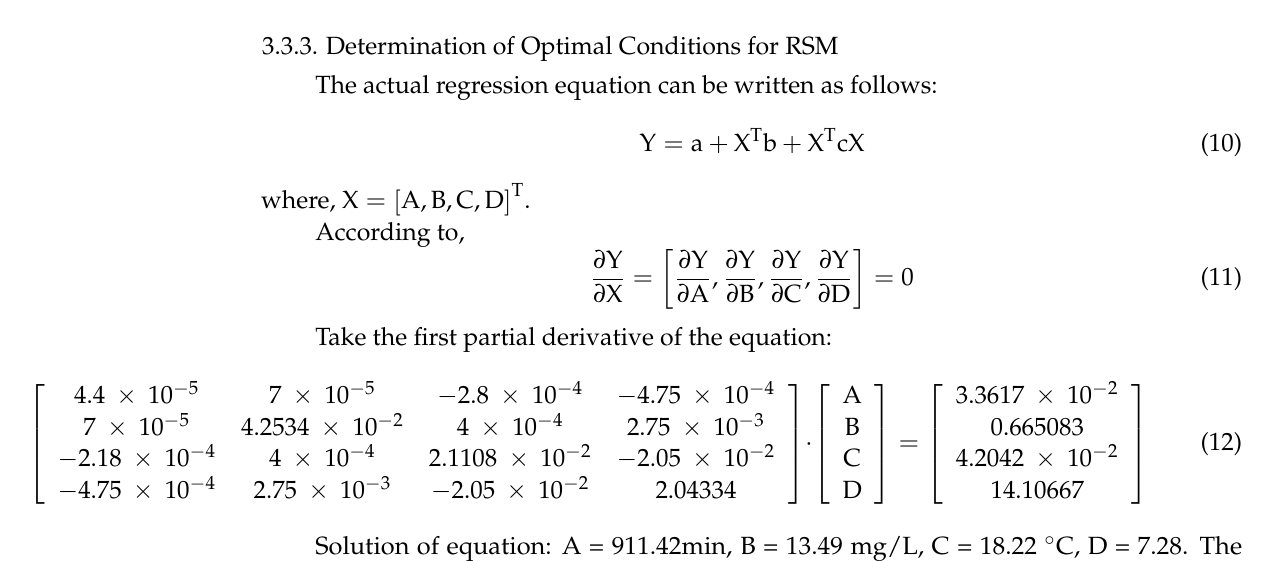
Figure 8. 2D contour plot ( a ) and 3D response surface plot ( b ) showing the effect of contact time and temperature on the removal rate of NH 4+ .